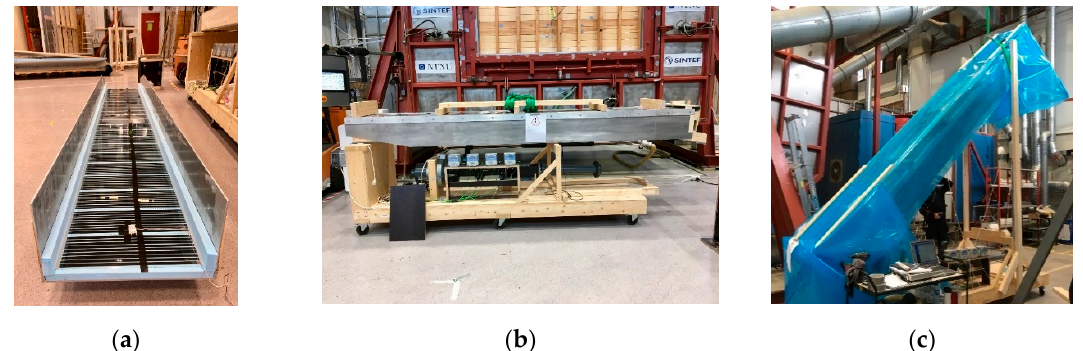
Figure 1. ( a ) Top aluminium lid showing the arrangement of XPS and heating foil on the inside of the air cavity; ( b ) complete test model, at 0° inclination; ( c ) inclined model with plastic foil cover, at 45° inclination.